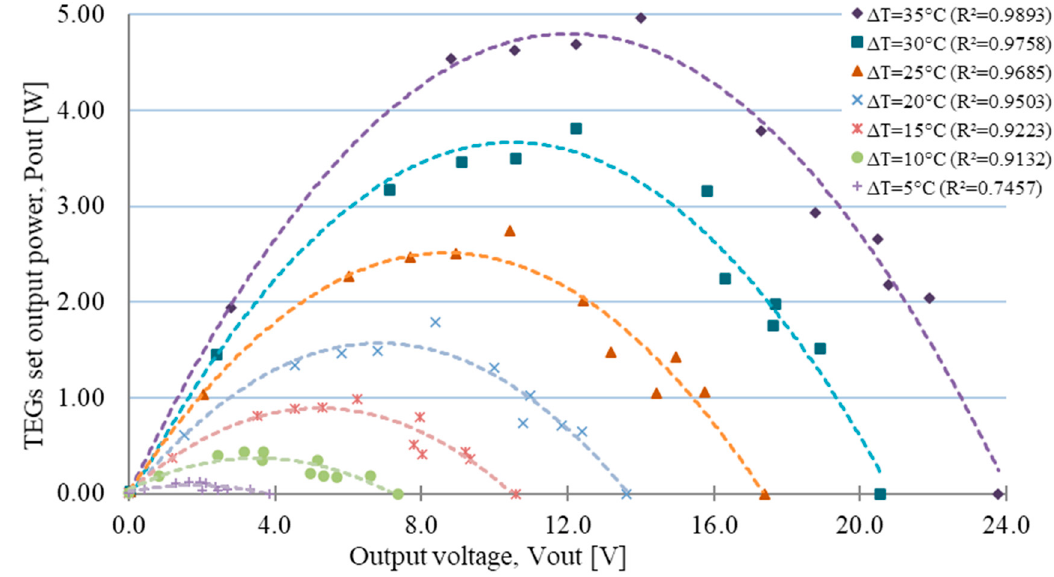
Figure 10. TEGs set output power as a function of voltage for various temperature differences.